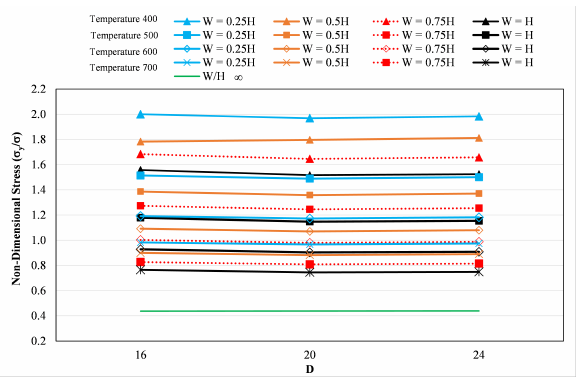
Figure 14: Relationship between σ y / σ with the pipe diameter